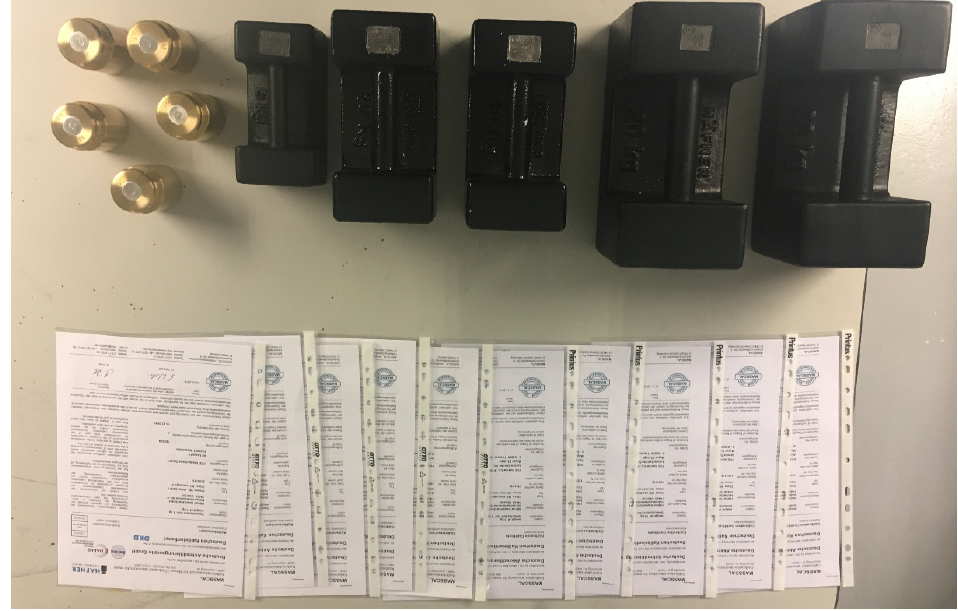
Figure 13. Calibrated weight set (Type: Class M2, calibration date 07/11/2019). Calibration curves were obtained based on the relationship between the application of loads and the reading of the three dynamometers. These curves were constructed using simple linear regression by the method of minimal squares and analyzed according to the following procedure: (1) scatterplots of dynamometer versus calibrator loads for each device; (2) estimation of the respective linear regression models and determination of residuals; (3) calculation of the r 2 value and verification of model’s assumptions; and (4) application of a covariance analysis model (ANCOVA), since the data provides Y d (load predicted value for a given dynamometer during the calibration process) and predictor x (the actual load value/washers). With this type of analysis, it was possible to model Y d as a linear function of x , where the coefficients of the regression line vary according to the device used. In this manner, the calibration was represented numerically by a table and graphically by a line described by the Equation (2):